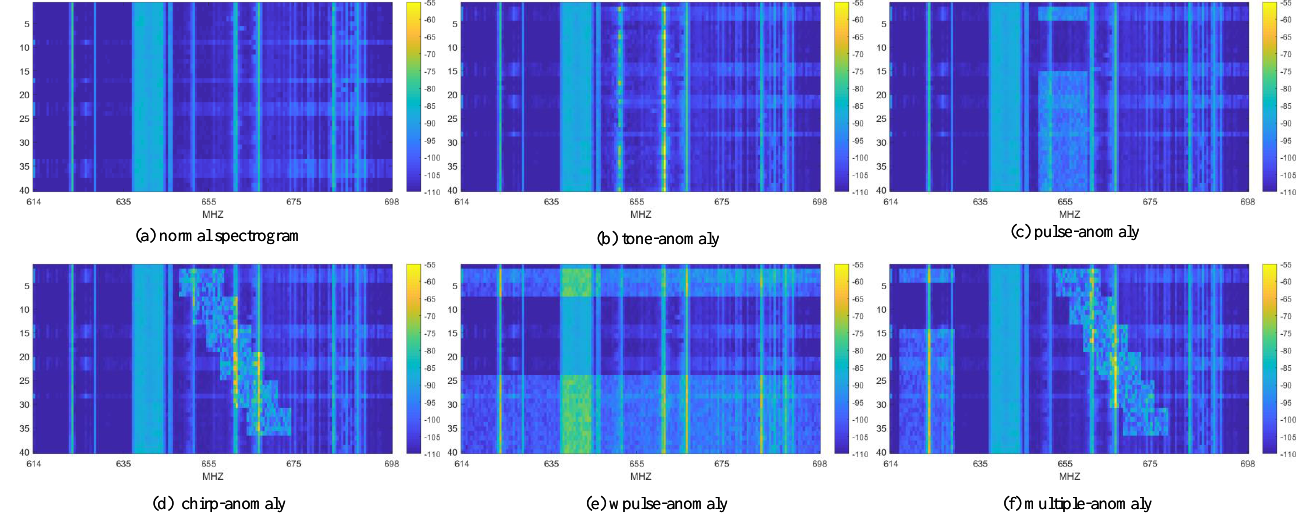
Figure 6. Example of a normal spectrum sample and an abnormal spectrum